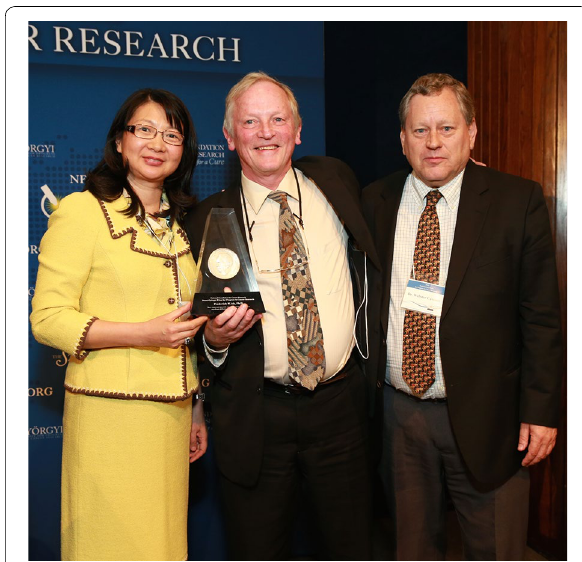
Fig. 1 From left to right Dr. Sujuan Ba, Co-chair of the 2015 Szent- Györgyi Prize Selection Committee and President of the National Foundation for Cancer Research (NFCR); Dr. Frederick Alt, winner of the 2015 Szent-Györgyi Prize; and Dr. Webster Cavenee, winner of the 2007 Szent-Györgyi